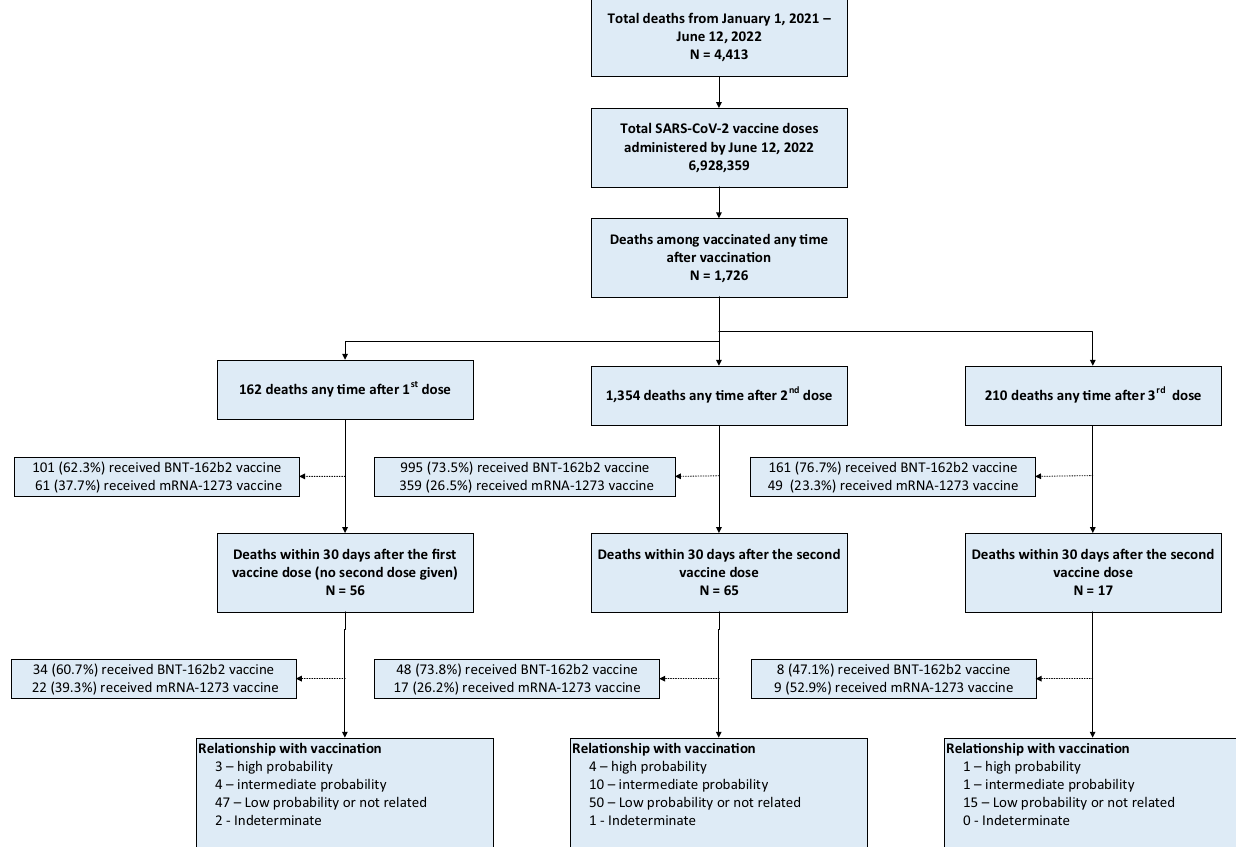
Fig. 1 | Algorithm used to classify the probability of death being associated with COVID-19